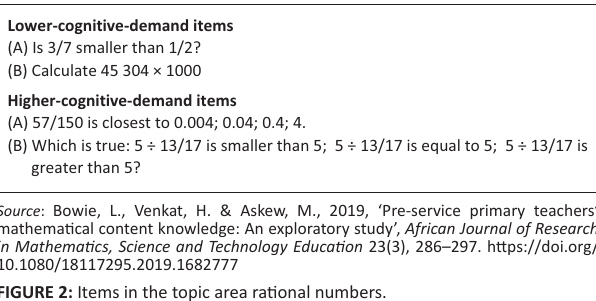
FIGURE 2: Items in the topic area rational TABLE 1: First- and fourth-year scores at three universities, per cent correct. Institution Level (year) Overall